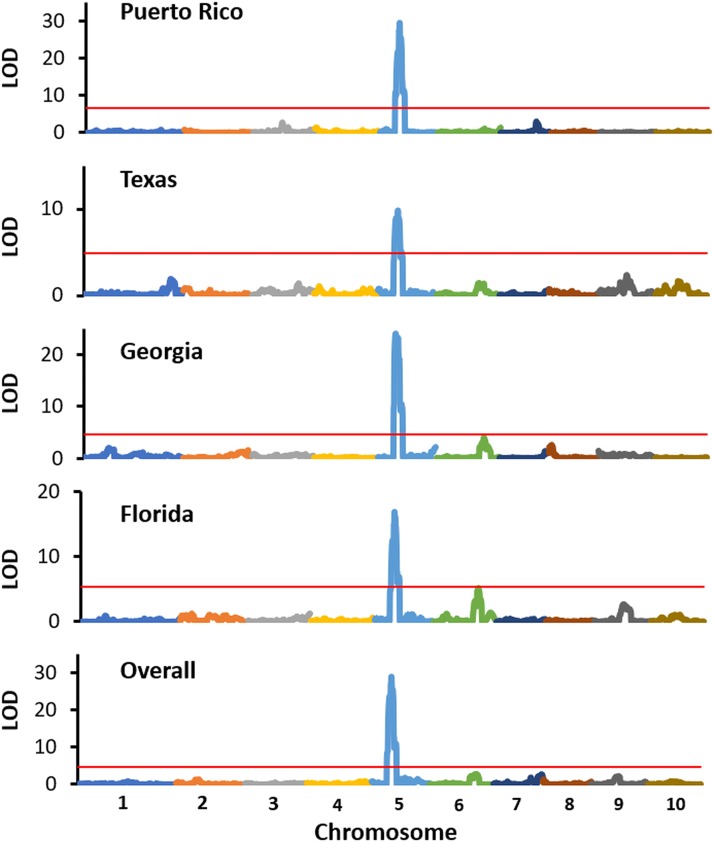
Composite interval mapping of anthracnose resistance response of 108 recombinant inbred lines (RILs) derived from the cross between SC112-14 and PI609251. Red horizontal lines mark an experiment-wise significance threshold of P <0.001 based on 1000 permutations.